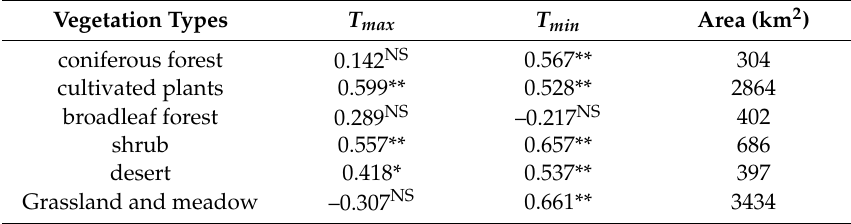
Table 1. Partial correlation coe ffi cients between NDVI and T max / T min for di ff erent vegetation types in the Yellow River over the period